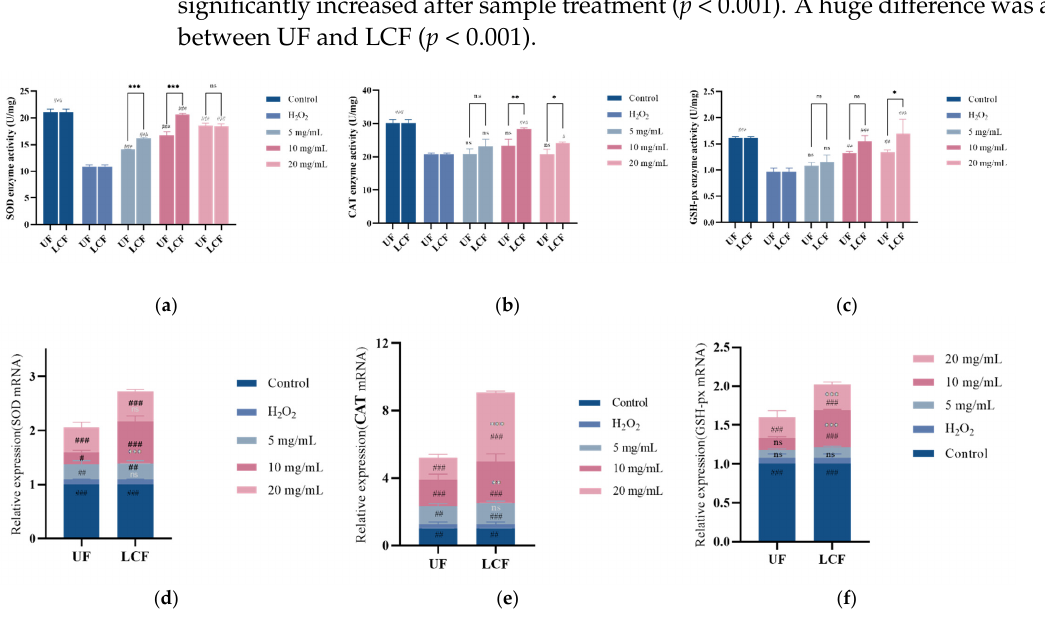
Figure 8. Effects of UF and LCF on antioxidant enzyme content and mRNA expression: ( a , d ) SOD content and mRNA expression; ( b , e ) CAT content and mRNA expression; ( c , f ) GSH-Px content and mRNA expression. UF: unfermentation; LCF: single microbial fermentation with L. curvatus . Analysis of significant differences between each group and H 2 O 2 model group, #: p < 0.05; ##: p < 0.01; ###: p < 0.001.; comparison of each group between UF and LCF, *: p < 0.05; **: p < 0.01; ***: p < 0.001; ns: p > 0.05.